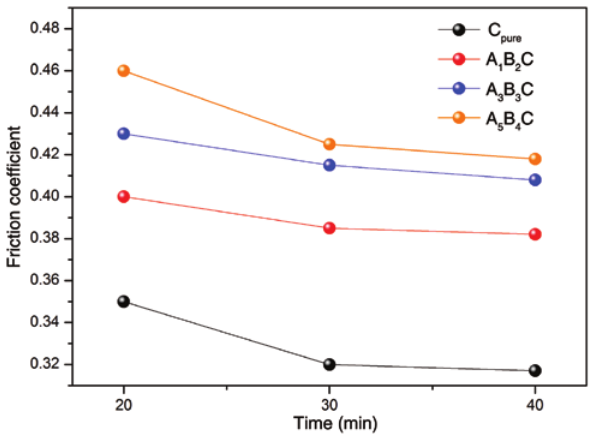
Figure 9: The relationship between friction coefficient of panto- graph and wear time.